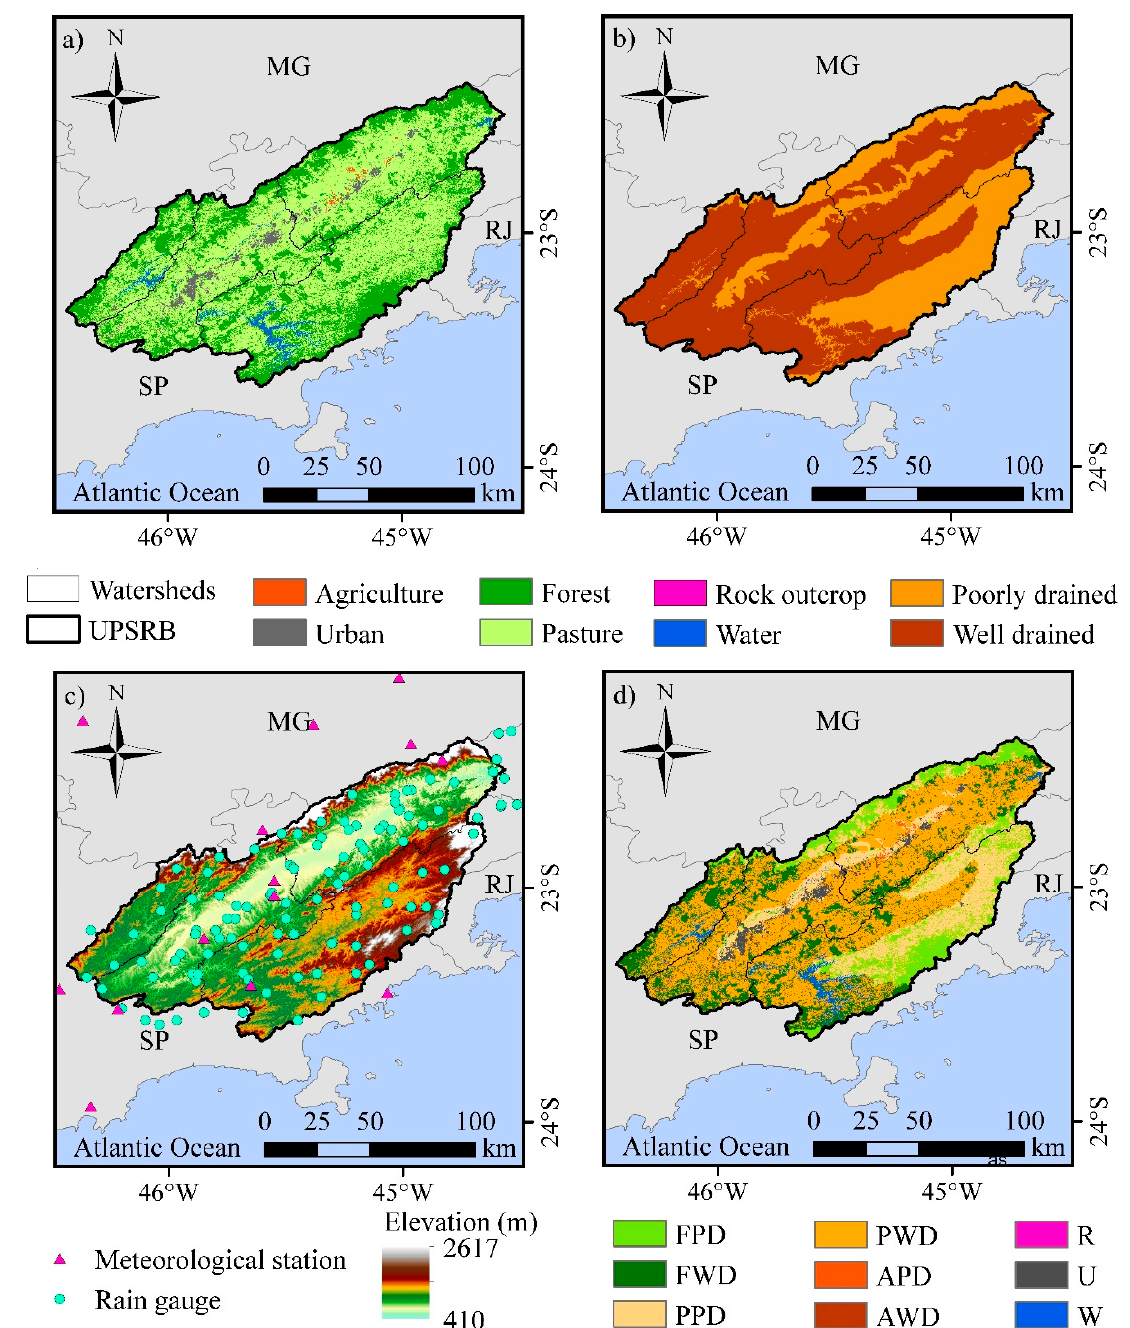
Figure 2. Model input data, including ( a ) land use and land cover, ( b ) drainage condition, ( c ) DEM, meteorological stations and rain gauges, and ( d ) hydrological response units (HRU) based on the combination of soil and land use and land cover maps: forest poorly drained (FPD), forest well drained (FWD), pasture poorly drained (PPD), pasture well drained (PWD), agriculture poorly drained (APD), agriculture well drained (AWD), rock outcrop (R), urban (U), and water bodies (W).